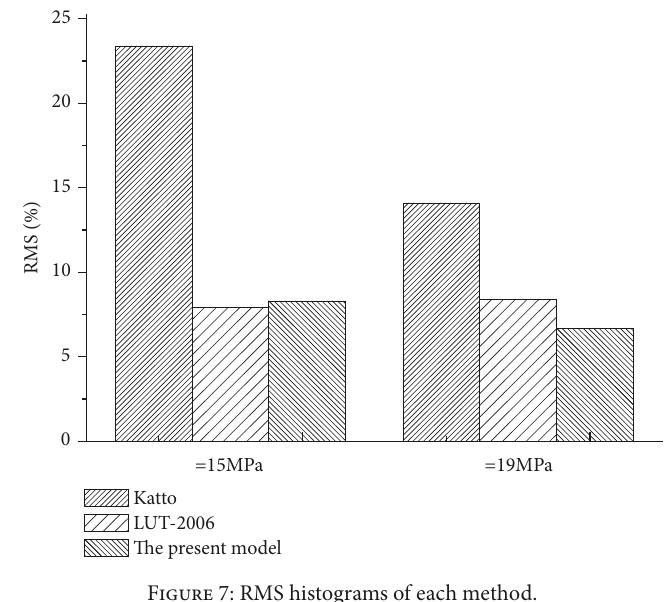
Figure 7: RMS histograms of each method.